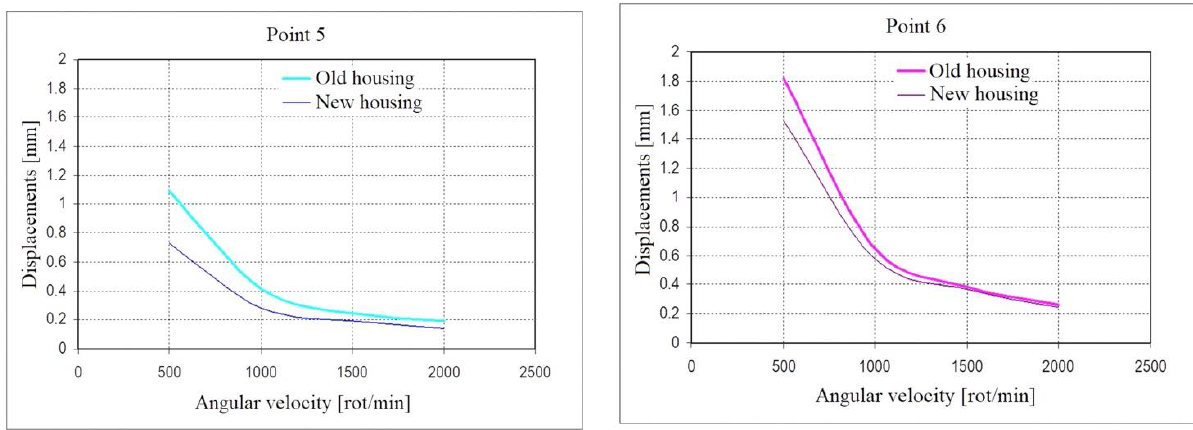
Figure 29. Displacements in measuring points 5 and 6 on the two summing boxes (old and new version).